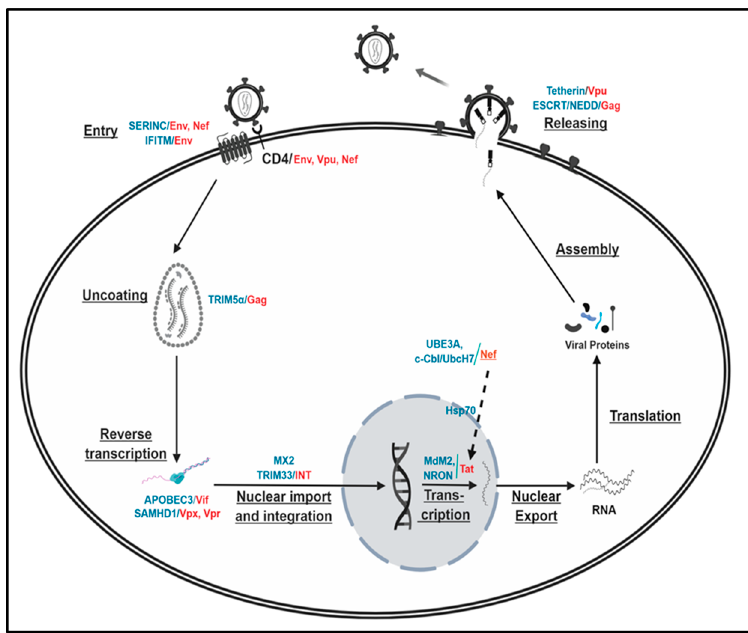
Figure 1. Schematic representation of the HIV-1 life cycle. Each step of the HIV-1 life cycle is underlined, and the viral and cellular proteins involved in each step of the proteasomal regulation are shown as red and teal, respectively. Proteasomal regulation between viral proteins is depicted as a dotted line. See the text for the detailed description of the role of the indicated viral and cellular proteins for the proteasomal degradation processes.